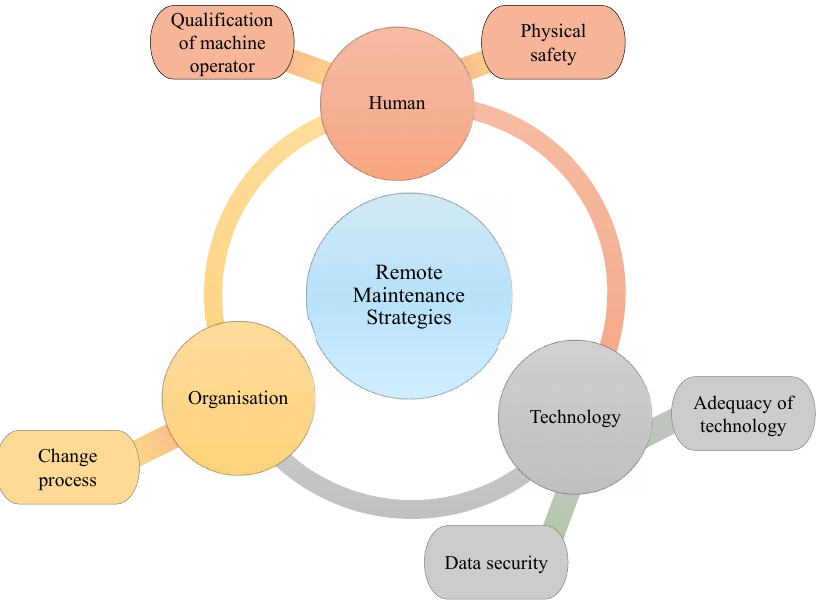
Figure 2. Characteristics for remote maintenance